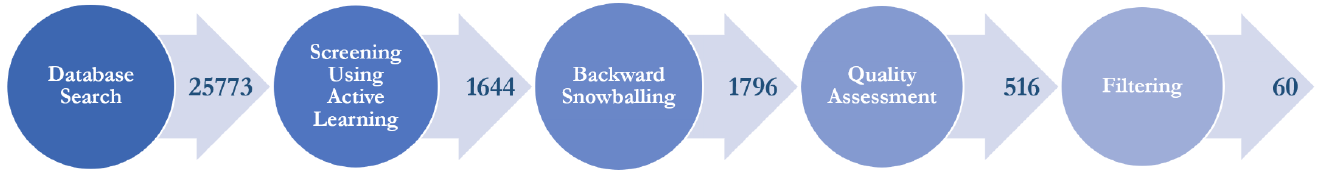
Figure 1. Visualisation of the SYMBALS steps as applied in our cybersecurity metric systematic